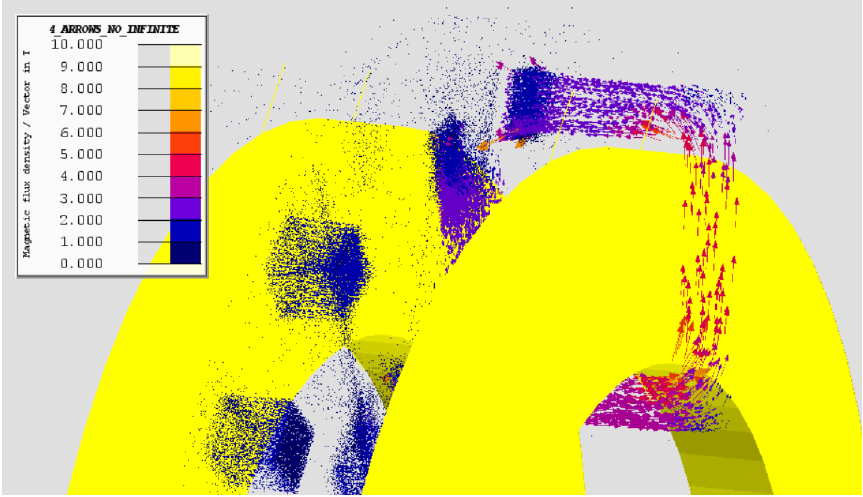
Figure 15. Magnetic flux density in the U-core (linear material), magnets and air.